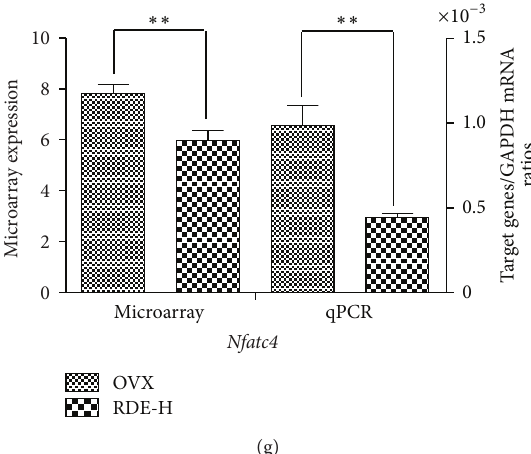
Figure 5: Validation of 6 differential expression genes identified by microarray and IPA in a replicated experiment by real-time qPCR. (a) Comparative changes in 6 genes as determined by microarray and qPCR ( 𝑛 = 6 in each group); (b)–(g) effect of RDE on the expressions of Sost, Lrp6, Tcf7l2, Alpl, Map2k6 , and Nfatc4 , respectively. ∗ 𝑃 < 0.05 ; ∗∗ 𝑃 < 0.01 , compared with the OVX